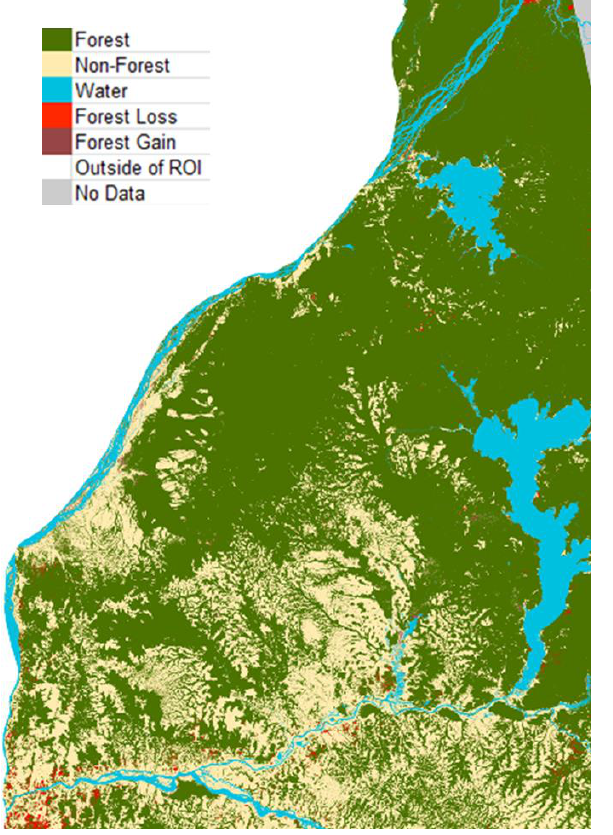
Figure 7. 2000-2010 Forest change map derived from optical and SAR based FNF maps from 2001/2012 and 2000/2010, respectively.